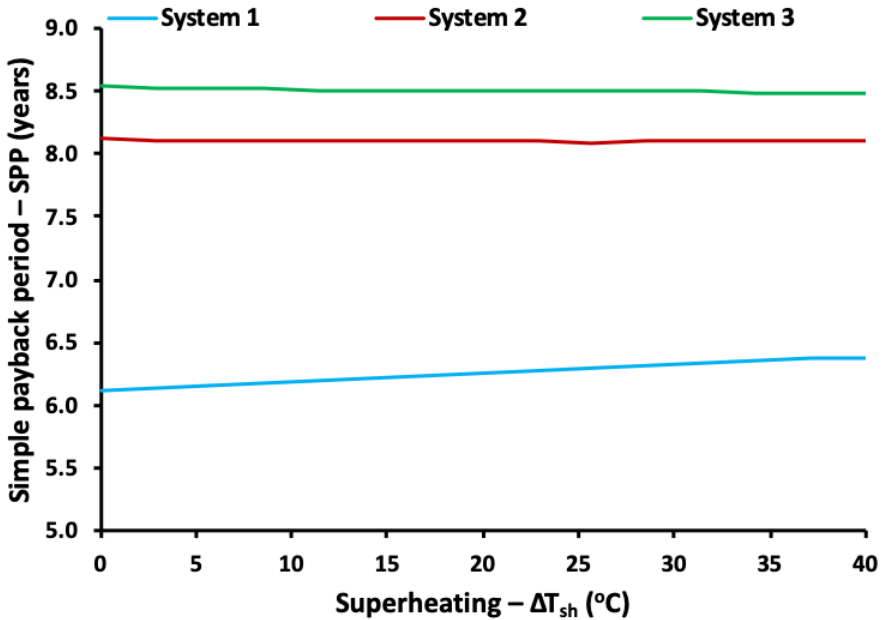
Figure 4. Simple payback period for the three systems with different values of the superheating in the turbine inlet.